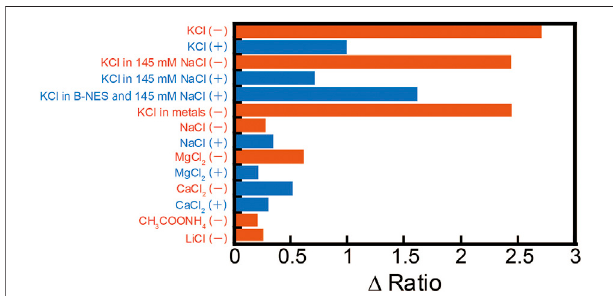
FIGURE 3 | Δ Ratio of 0.2 μ M 1 in the absence ( − ) or presence (+) of 0.3 μ M streptavidin (StAv) in 20 mM Tris-HCl (pH 7.4) under several